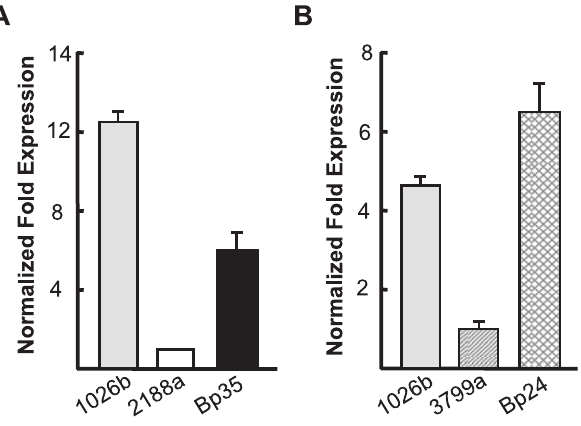
Figure 1. amrB transcript levels in gentamicin susceptible and resistant strains. mRNA levels in LSLB without antibiotics-grown late- log cultures of the indicated strains were determined with an amrB - specific primer set. Data were normalized using the 23S rRNA gene as the housekeeping control. amrB transcript levels were determined A in strain 2188a and its gentamicin resistant derivative Bp35 and B in strain 3799a and its gentamicin resistant derivative Bp24. Relative quantifi- cations were performed using 2188a and 3799a,